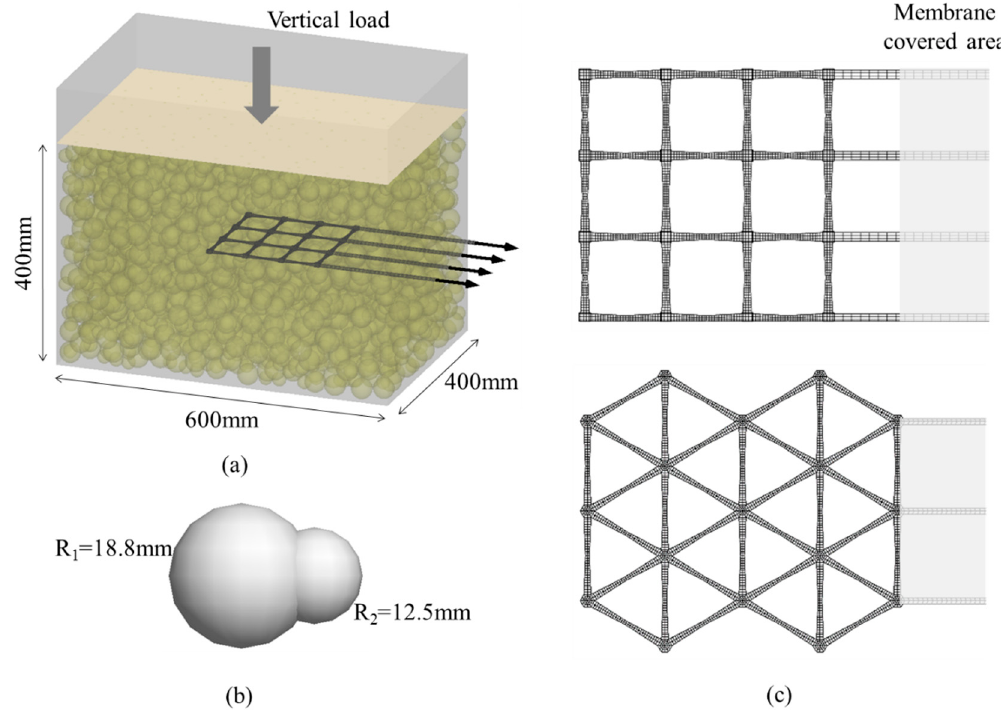
Figure 5. DEM-FDM of large box pullout test: ( a ) embedded geogrid specimen and simulated surcharge; ( b ) 2-ball clump used in the simulation and ( c ) FDM geogrid model used in the simulation .